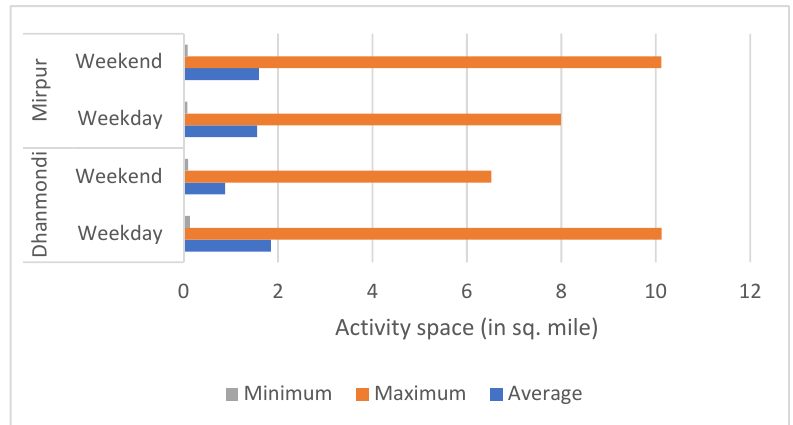
Figure 3. Descriptive of individual activity space of survey respondents.